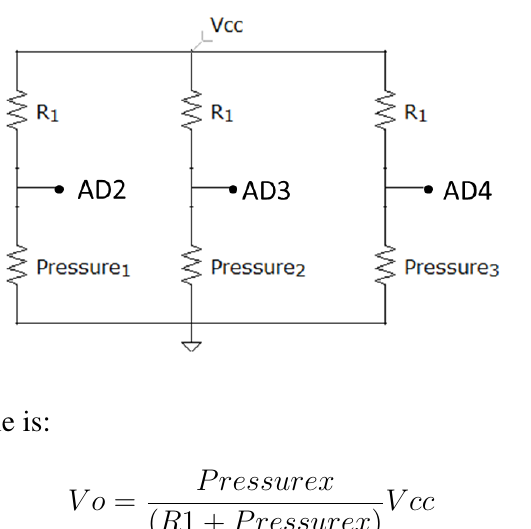
Figure 8. Pressure sensors